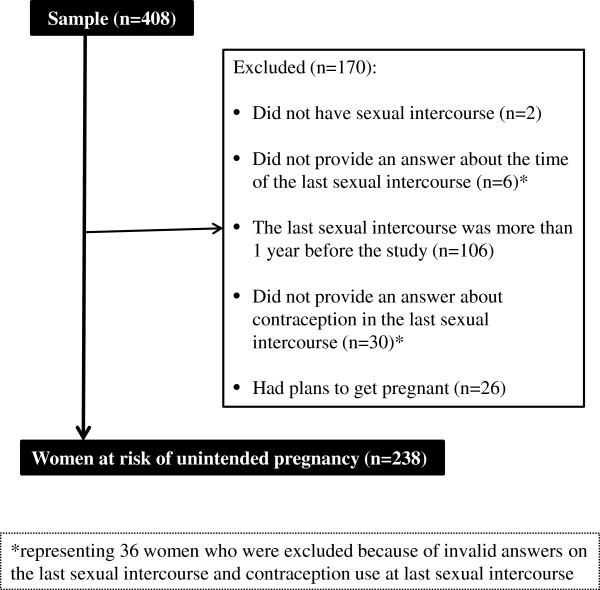
Details of the subject recruitment process.